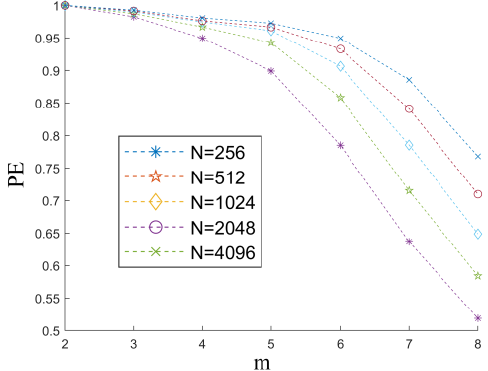
Figure 8. Alignment entropy of vibration signals of various lengths.